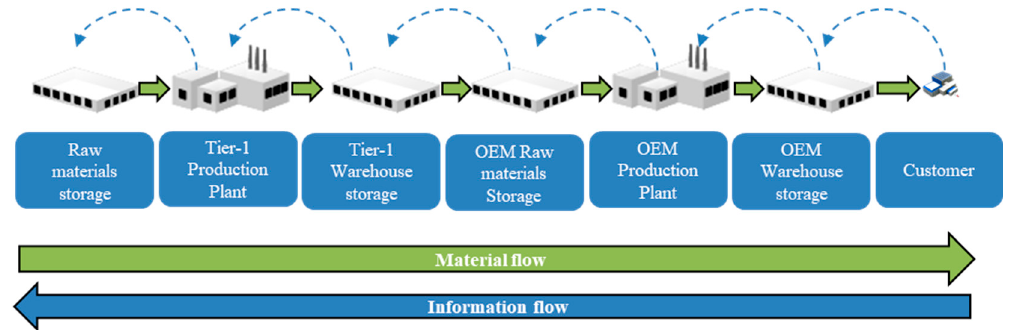
Figure 3. Supply chain structure of the case study (own elaboration). Original equipment manufacturer (OEM).